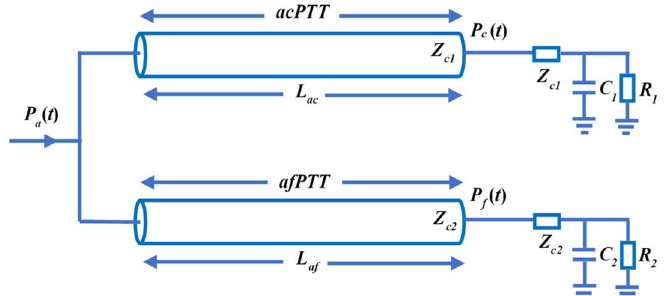
Figure 8. Parallel dual tube-load model for estimating PTT from the aorta to carotid and femoral arteries. The first tube represents the travel path between the aorta and carotid arteries. The second tube represents the travel path between the aorta and femoral arteries. The acPTT and vessel length L ac represent the time delay and travel distance between the aortic P a ( t ) and carotid P c ( t ) pressure waveforms, respectively. The afPTT and vessel length L af represent the time delay and travel distance between the aortic P a ( t ) and femoral P f ( t ) pressure waveforms, respectively.